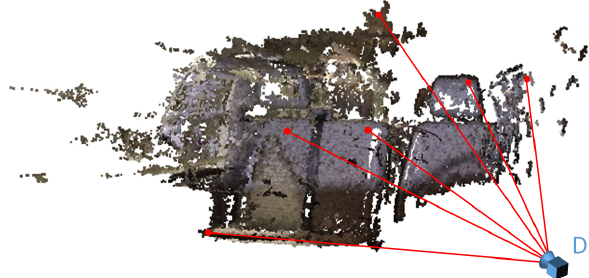
Figure 7: Point cloud of the front seat row of the test car, view from outside through the windshield to the interior. Three seats can be seen in the figure, the driver’s seat is on the right side. 3d points (examples: red circle) of this point cloud are used to estimate the pose of the interior driver camera D . In average, 180 points per image are used for pose estimation.